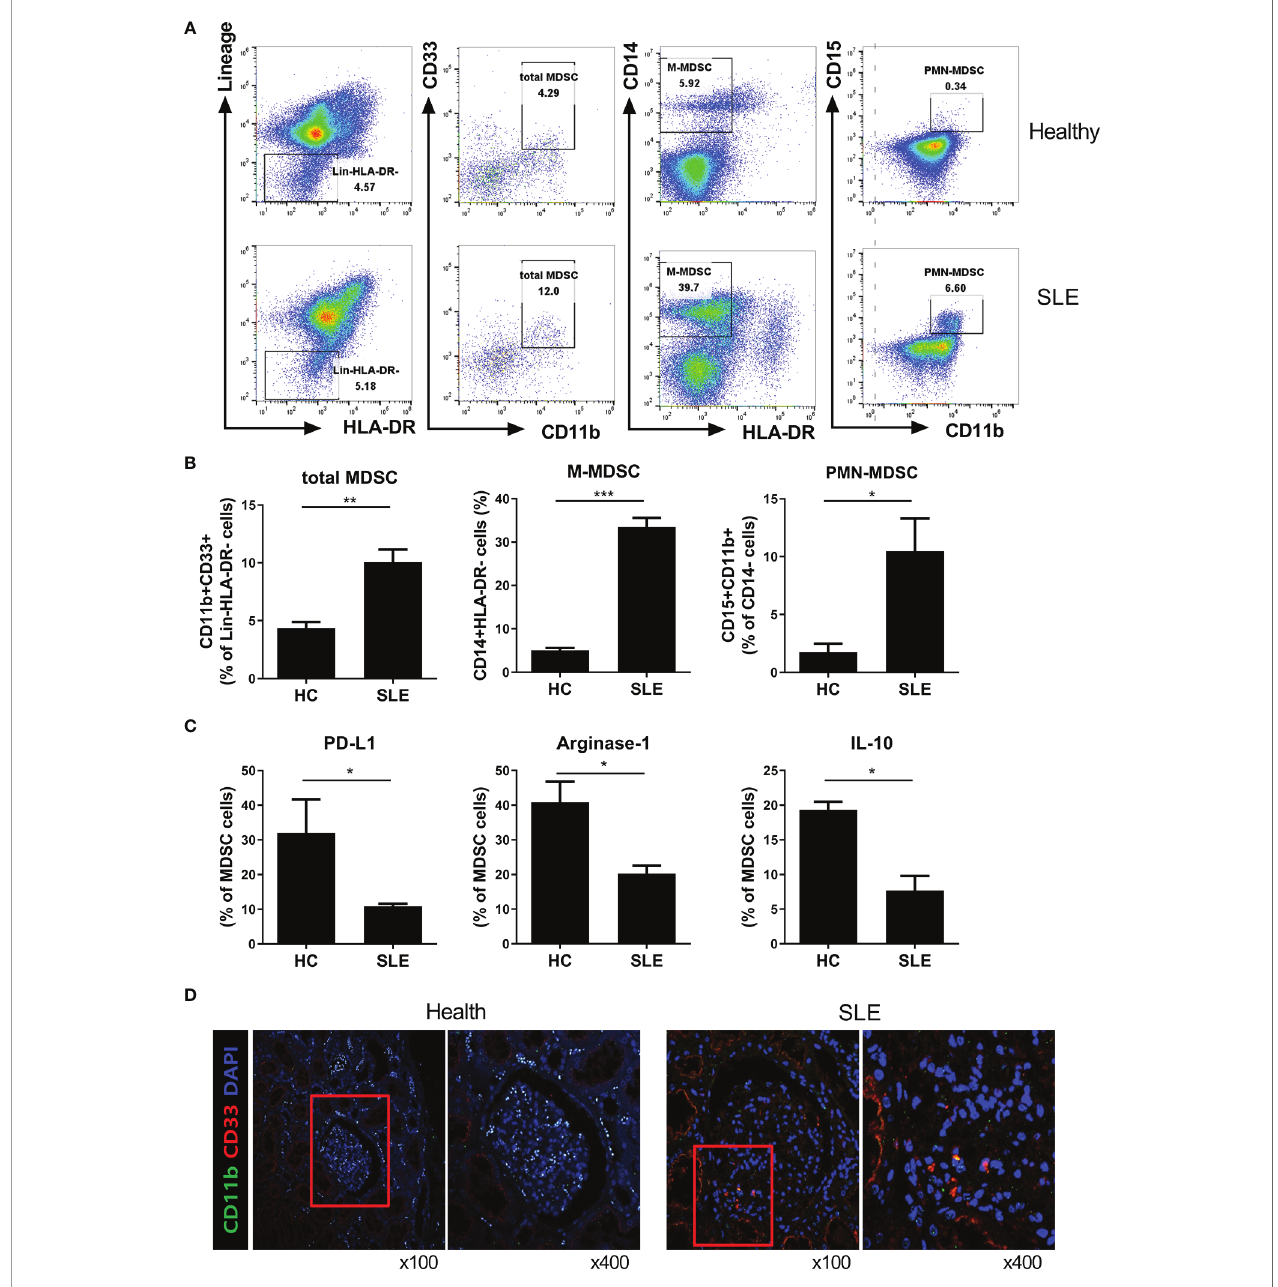
FIGURE 6 | Characterization of MDSCs from SLE patients. (A) MDSCs subpopulations of human peripheral bloods was determined by fl ow cytometry in SLE patients and healthy controls (Total MDSC: HLA-DR-Lin-CD33+CD11b+ cells, M-MDSC: CD14+ HLA-DR- cells, PMN-MDSC: CD14-CD15+CD11b+ cells). Gating strategy of human MDSCs and representative fl ow cytometric plot is shown. (B) Relative bar graph indicates the frequency of MDSC subpopulation in healthy controls and SLE patients. (C) The expression of PD-L1, arginase-1, and IL-10 was determined by fl ow cytometry. The percentage of PD-L1, Arginase-1, and IL-10 expressing MDSCs is shown. (D) Representative confocal microscopy analysis for MDSC like cells in kidney of patients with lupus nephritis and healthy controls. Cells were stained with fl uorescence-tagged antibodies to identify DAPI, CD11b (FITC) and CD33 (PE). CD11b+CD33+ cells, MDSC like cells, are located in kidney tissue sections, especially in patients with lupus nephritis (x100(left), x400(right), original magni fi cation). (* P < 0.05, ** P < 0.01, *** P <